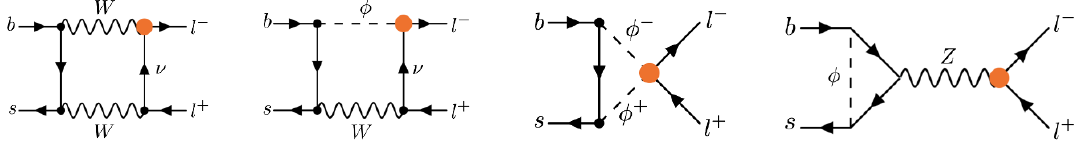
. The (cid:12)rst two Hl